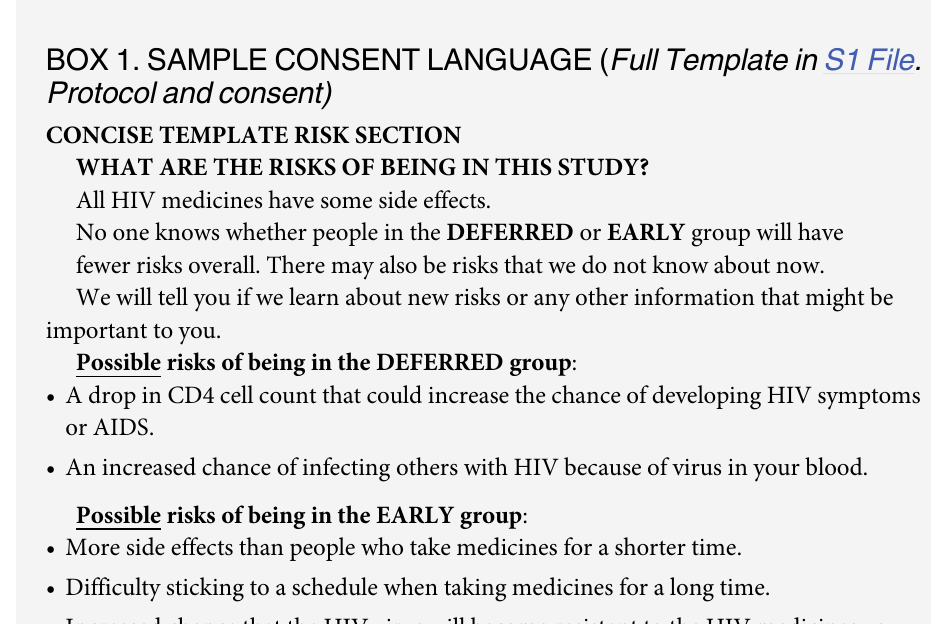
BOX 1. SAMPLE CONSENT LANGUAGE ( Full Template in S1